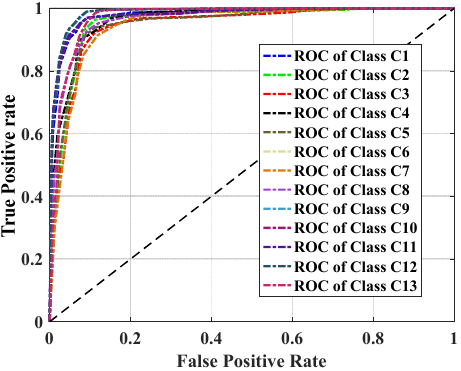
Figure 12. Receiver operating characteristic curve for each PQD class.